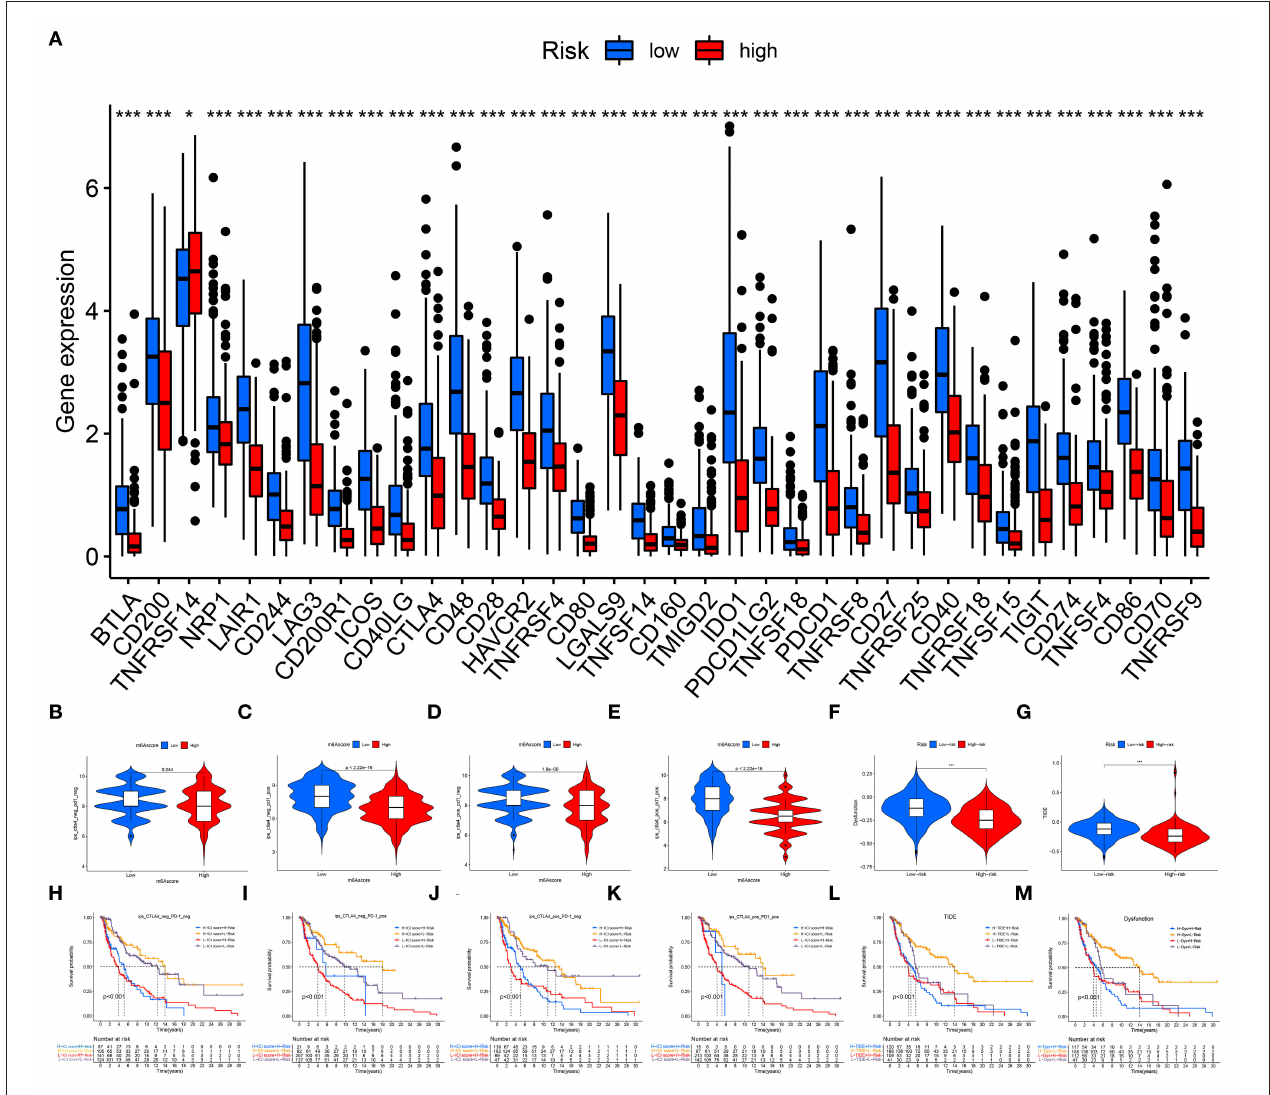
FIGURE 8 | Immune checkpoint blockade. (A) A total of 36 immune checkpoints, including PD-L1, PD-1, and CTLA-4, were differentially expressed between high- and low-risk patients. (B–E) Immunotherapeutic effect of anti-PD-1 and anti-CTLA-4 antibodies in high- and low-risk patients. (F) TIDE evaluation. (G) Dysfunction evaluation. (H–M) The prognostic performance of immunotherapy cohorts. ns, not significant; * p < 0.05; *** p <